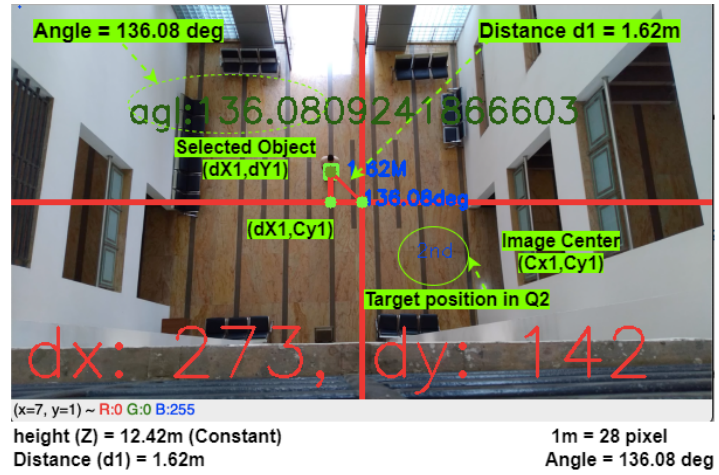
Figure 8. Estimation of target position parameters in drone images using Equations (1)–(3).